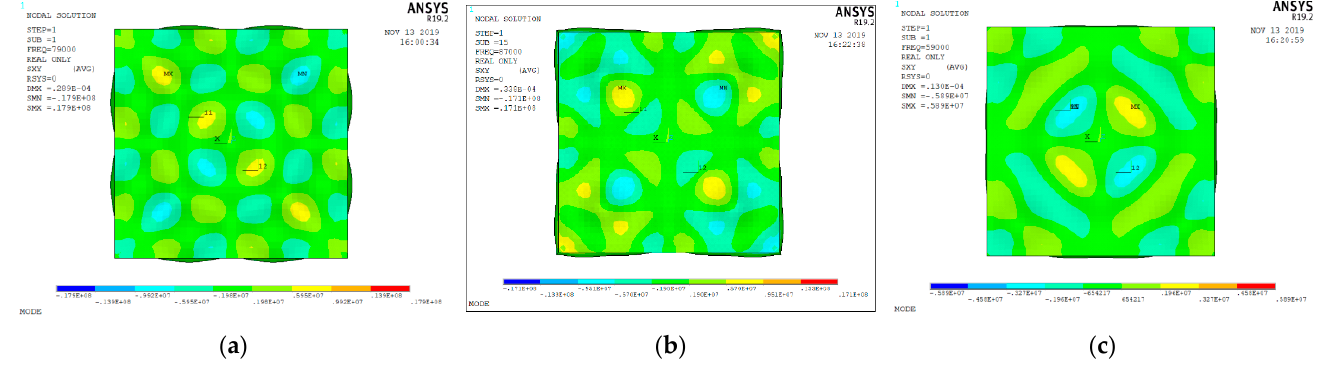
Figure 8. Distributions of shear stress at the adhesive interface: ( a ) side length is 14 mm, and frequency is 79 kHz; ( b ) side length is 16 mm, and frequency is 87 kHz; ( c ) side length is 16 mm, and frequency is 59 kHz. Table 2. Parameters and maximum shear stresses.